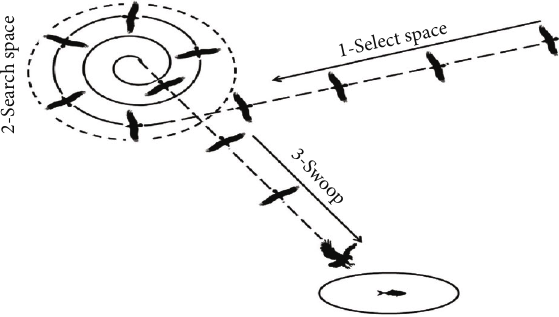
Figure 5: The three main stages of BES hunting